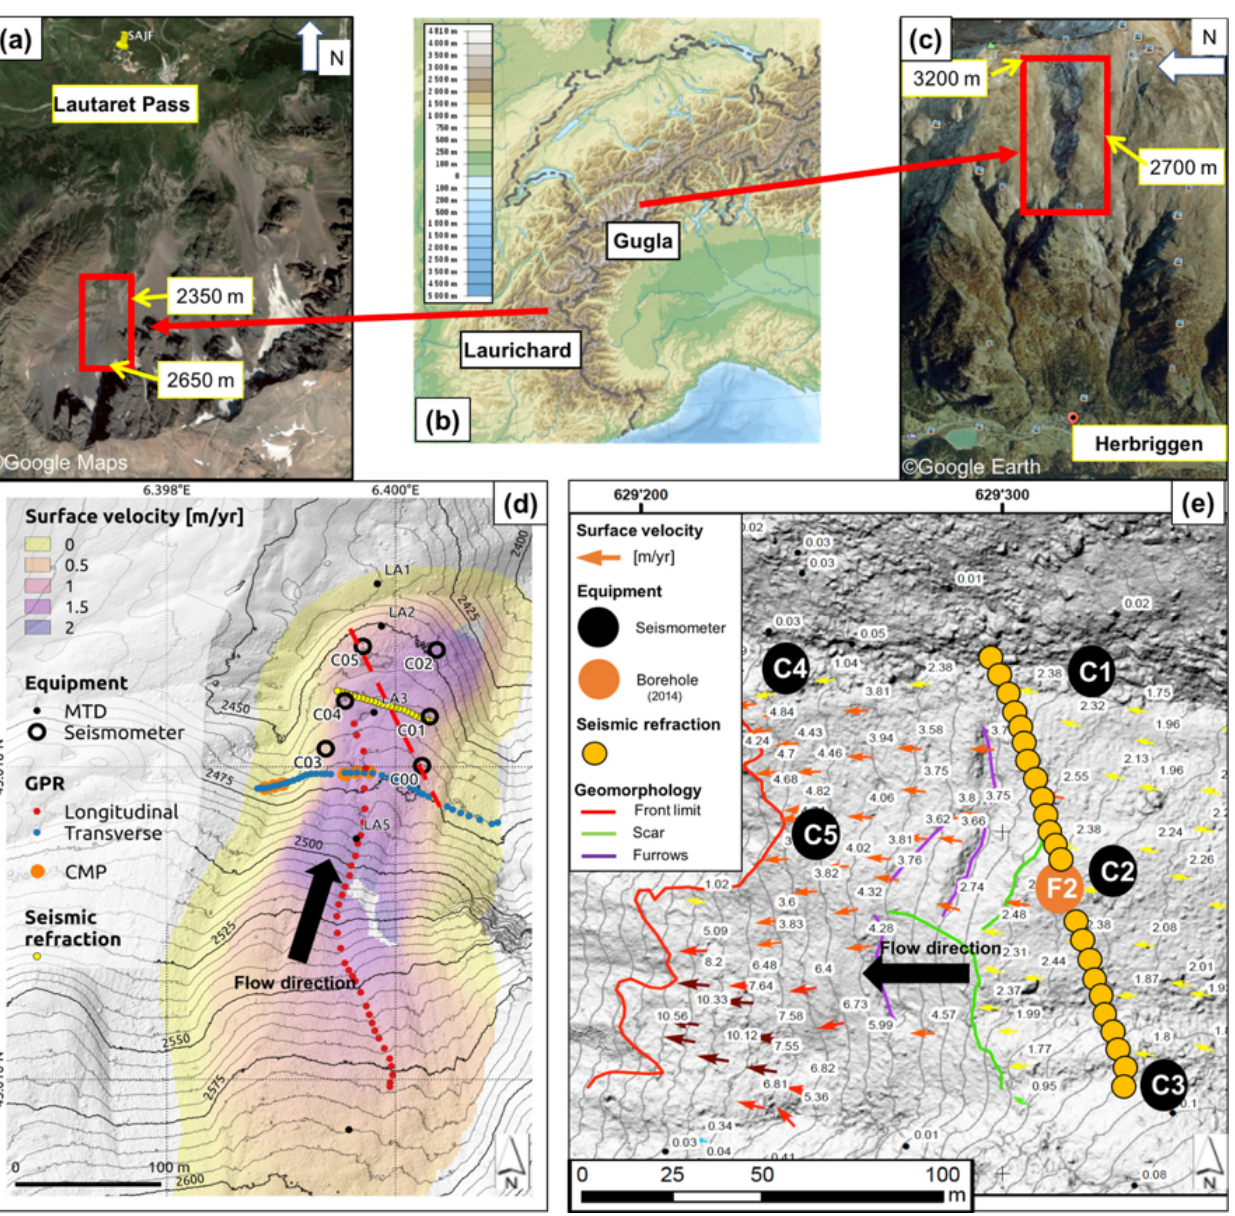
Figure 1. (a, c) Aerial views of the two sites (from © Google Maps and © Google Earth). (b) Global topographic map of the western part of the Alpine belt, centered around the French and Swiss Alps. (d) Digital elevation model of the Laurichard rock glacier and location of the miniature temperature data loggers (MTDs) that monitor ground thermal regime at the subsurface, the seismometers, and the geophysical surveys – ground-penetrating radar (GPR, red and blue points) and seismic refraction profile (yellow points). The mean annual surface velocity fields (over the period 2012–2017) is revealed by the background color. The six continuous seismometers are marked by large circles (C00 to C05). The dashed red line depicts the C00–C05 profile used for the bedrock depth estimation (see Fig. 5). (e) Digital elevation model of the Gugla rock glacier (front in red line) and location of instrumentation, the seismic refraction profile and geomorphologic features. The mean annual surface velocity measured between 2014 and 2015 by photogrammetry (CREALP, 2016) is also shown on this map.